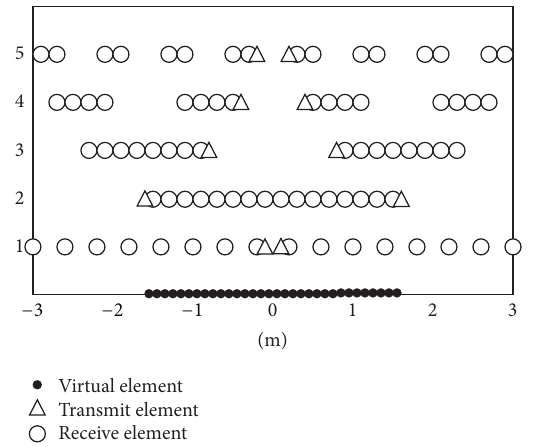
Figure 2: Linear MIMO arrays with the same virtual aperture array.